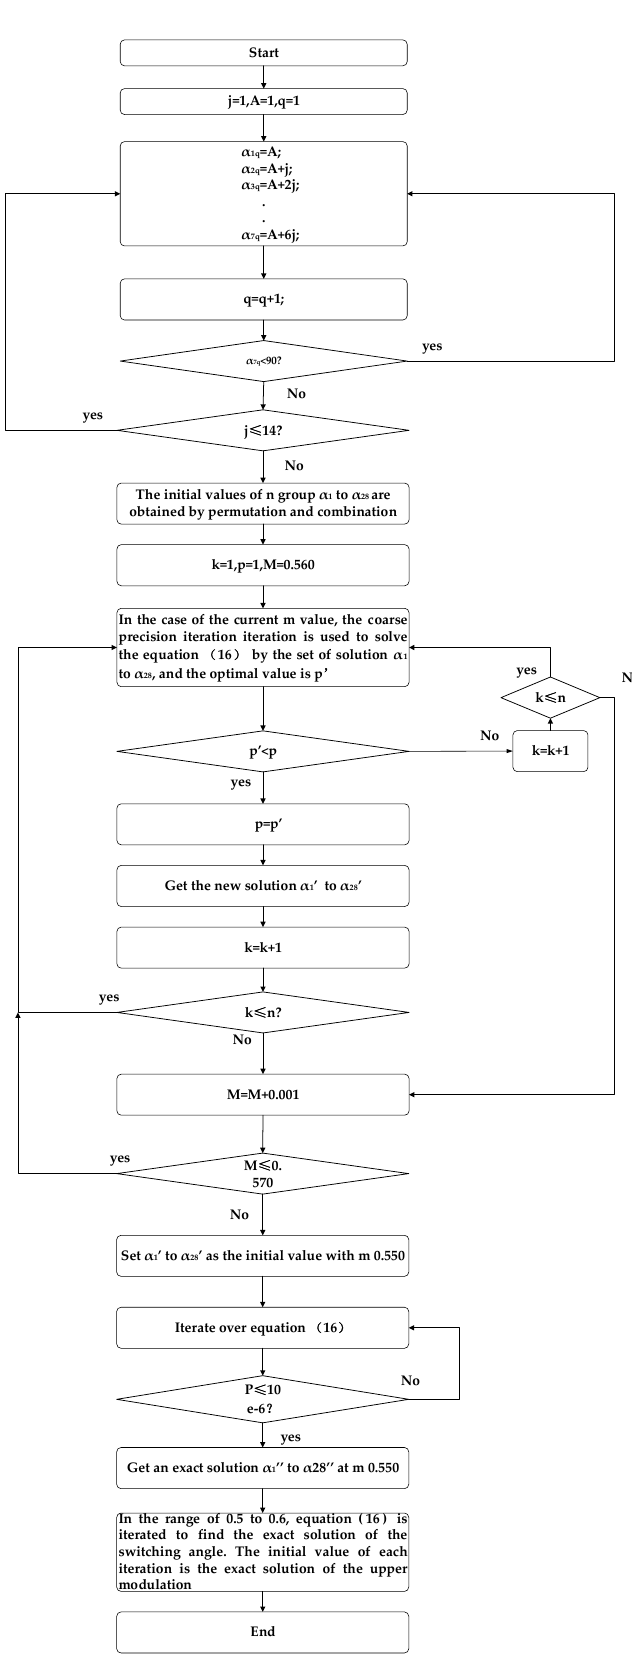
Figure 12. Flow chart of solving process.